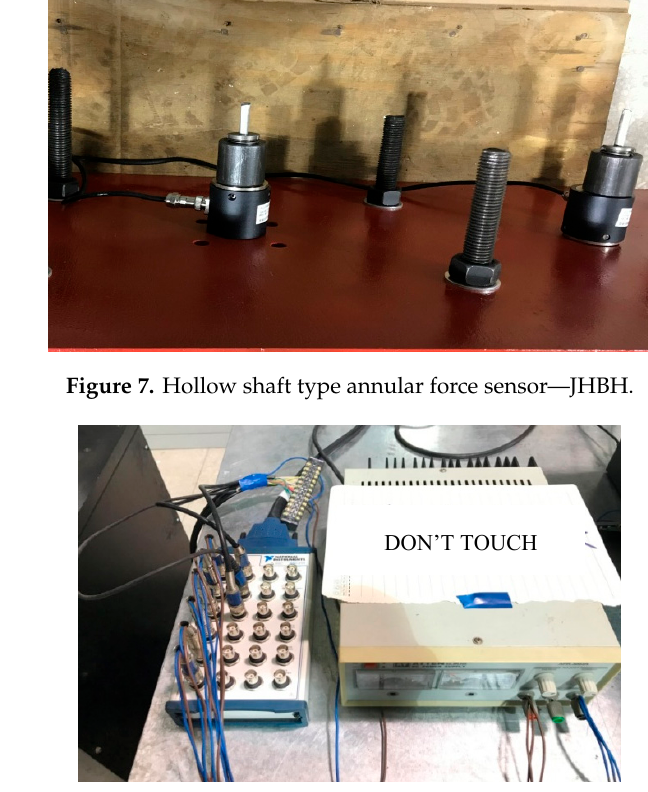
Figure 9. Process and work principle of data collection by LabVIEW. ( a ) Forces applied to multiple wires ( b ) Force applied to one wire Figure 10. Display interface of fatigue loads recorded by LabVIEW. 2.2.4. Corrosive Solution According to the different purpose of the test, the corrosion test in the laboratory includes a chemical immersion test, semi-immersion test, inter-immersion test, etc. As shown in Figure 11, these tests can be used to simulate different corrosion conditions that may be encountered in practical applications. The method used in this paper belongs to the first type of corrosion test [26]. In this method, gauze or cotton is used to wrap the zone where the steel wire needs to be corroded. The corrosive solution is then dropped on the surface of gauze or cotton, and rapidly diffuses in the gauze or cotton to ensure full contact with the wire. Gauze or cotton can not only absorb the corrosive